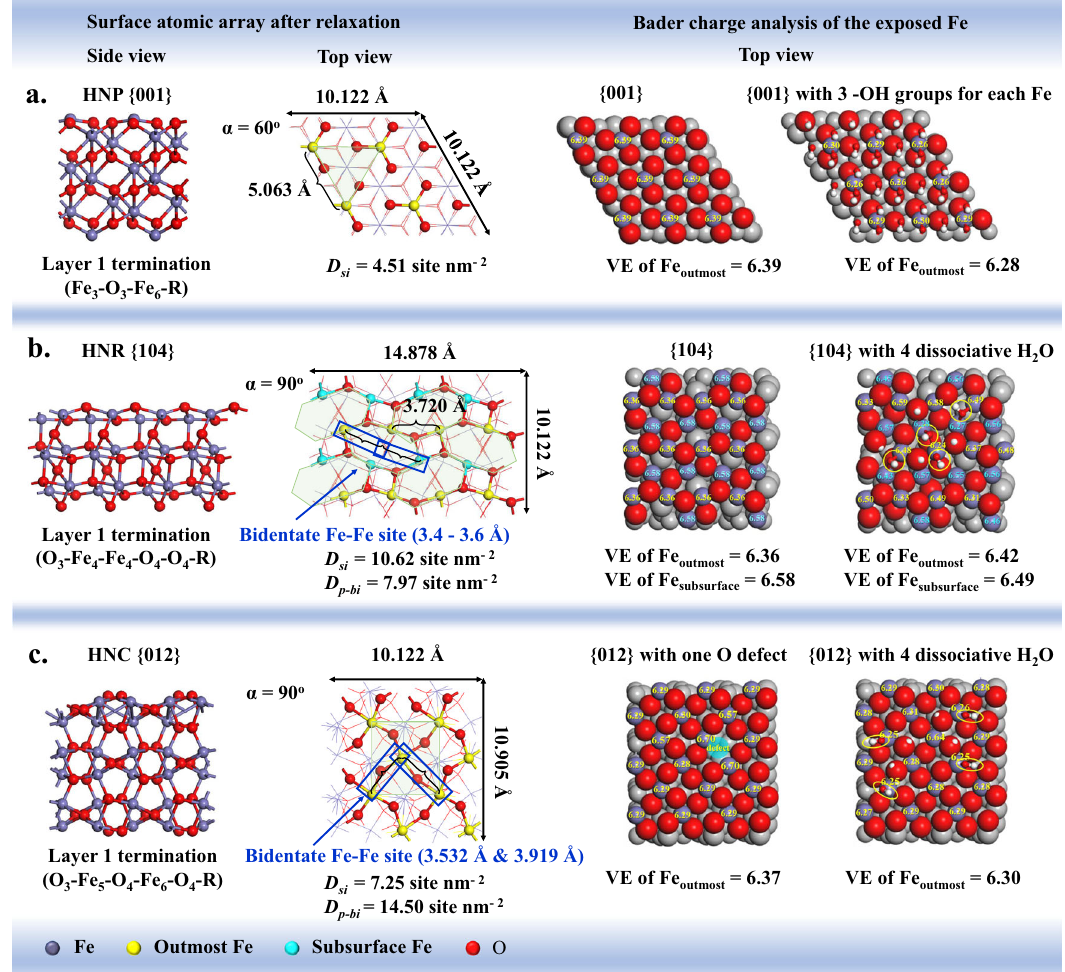
Fig. 3 | Structural array and Bader charge analysis. The slab models include ( a ) the {001} facet layer 1 termination of hematite nanoplate (HNP), b the {104} facet layer 1 termination of hematite nano-rhombohedra (HNR), and c the {012} facet layer 1 termination of hematite nano-cube (HNC). The neighboring Fe – Fe distance